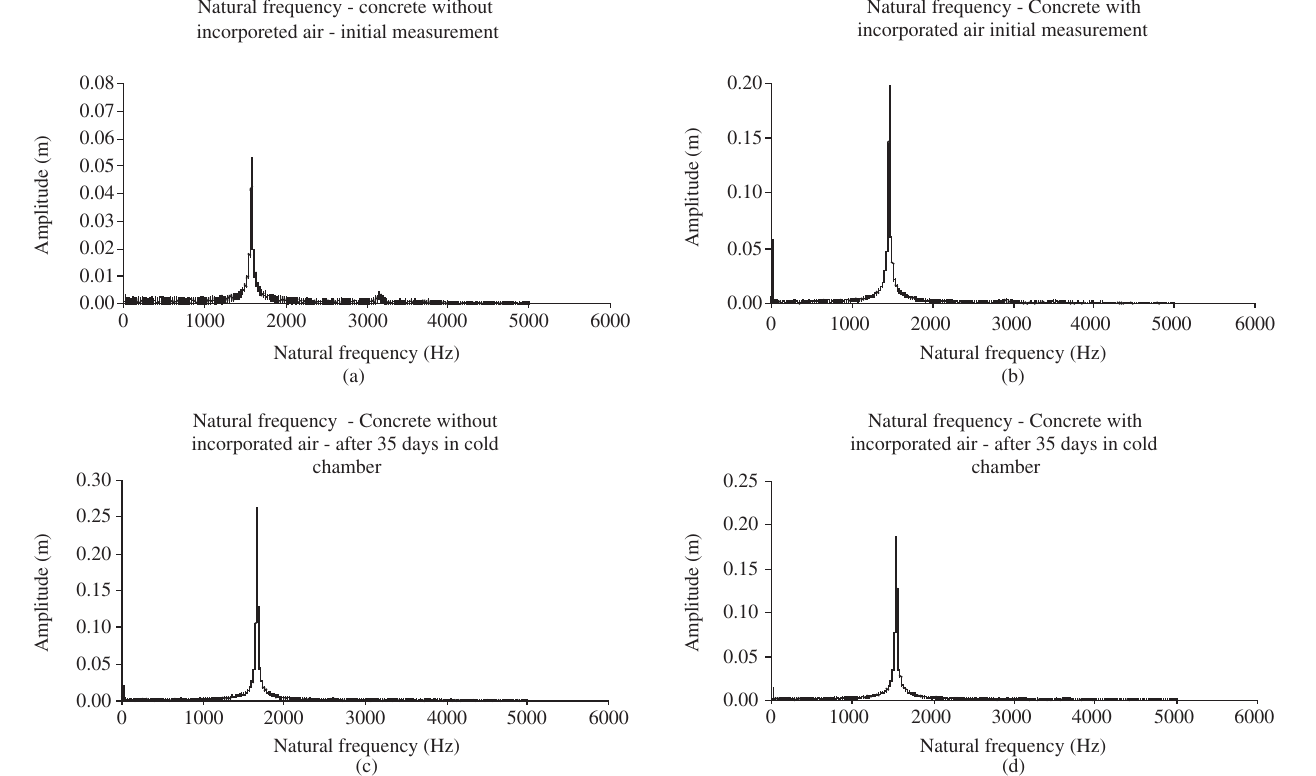
Figure 9. Curves to obtain the natural frequency in various ages for tested concrete at low temperatures. Source: Lima 9